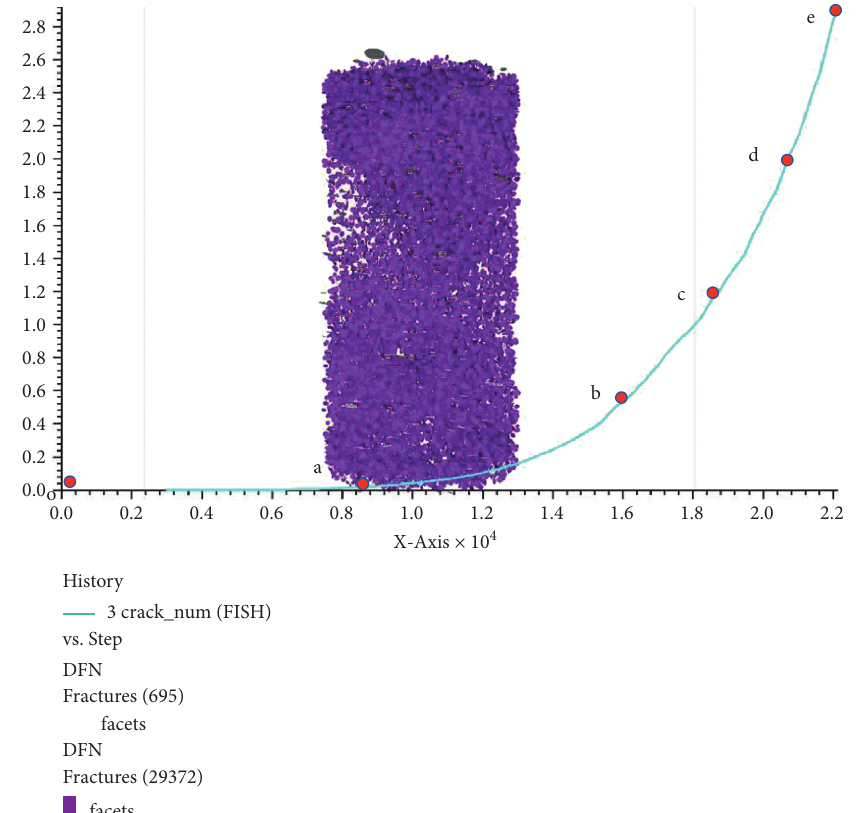
Figure 14: Statistical curve of the number of nodules in coal sample